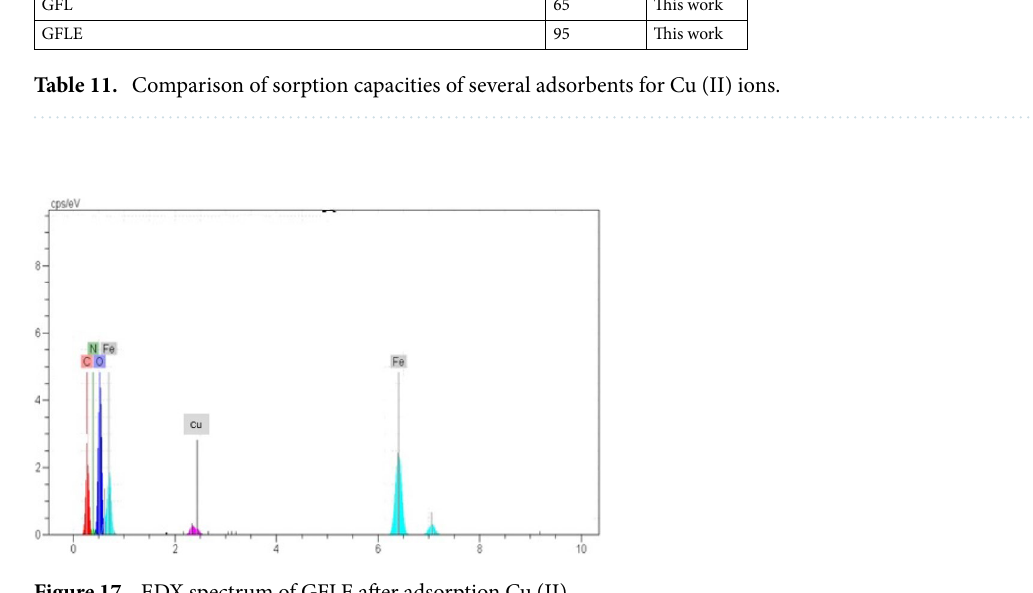
Figure 17. EDX spectrum of GFLE after adsorption Cu